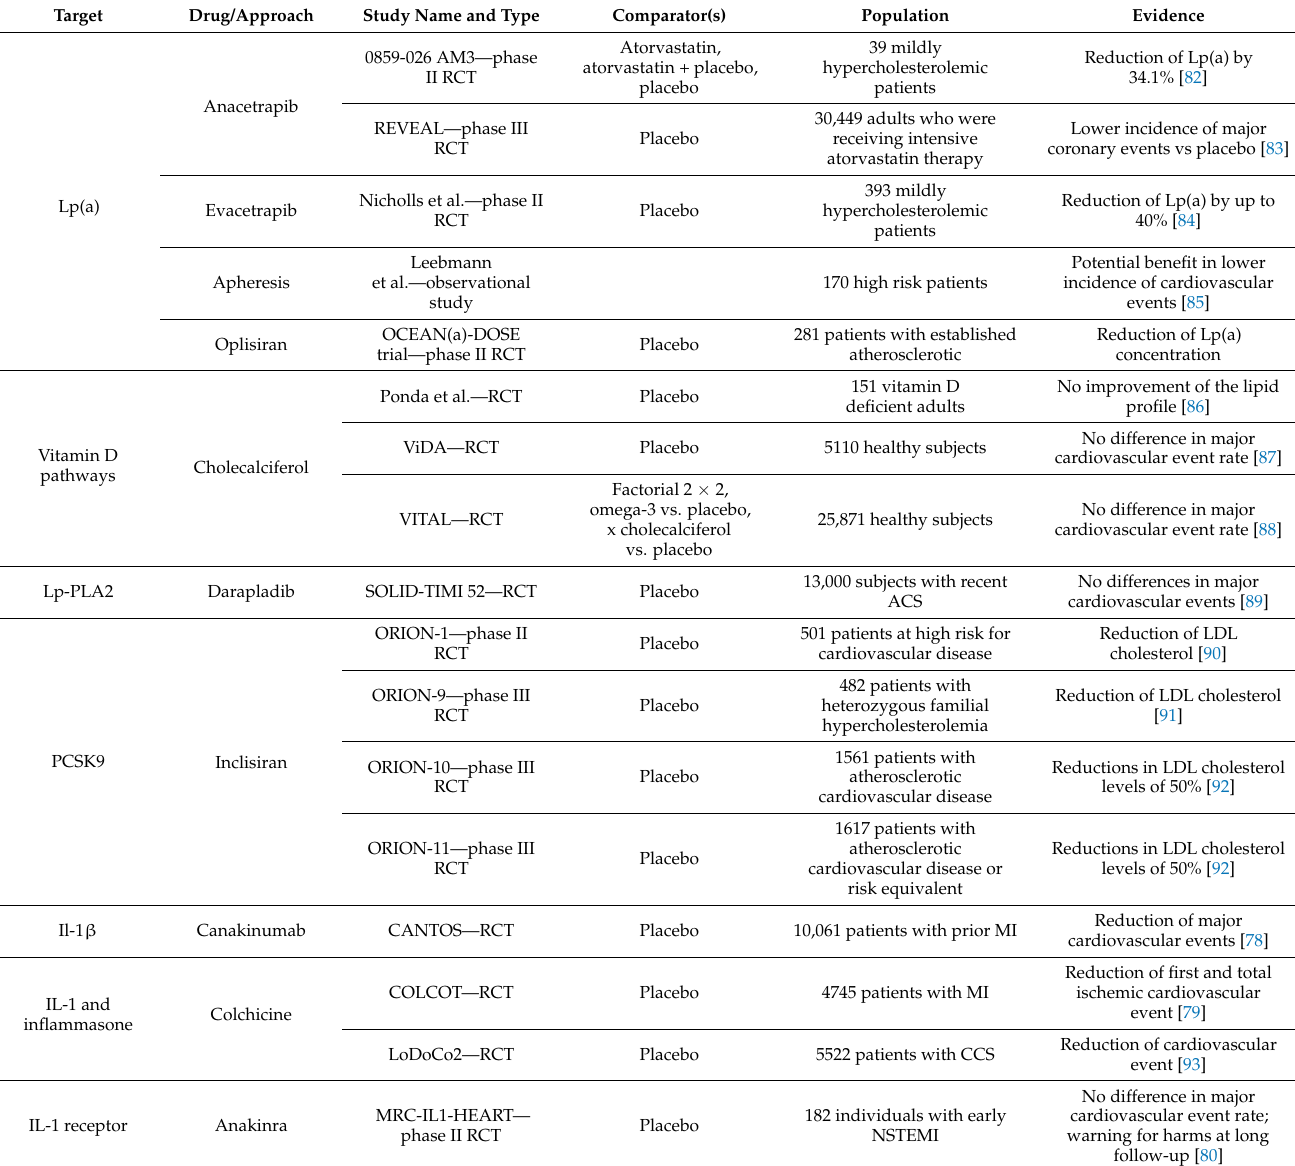
Table 1. Main clinical study and evidence in humans of the discussed